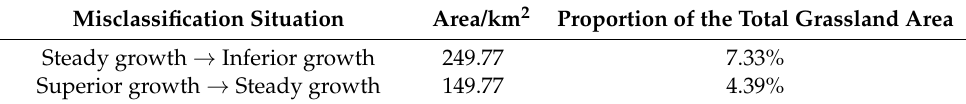
Table 9. Statistics of grassland growth misclassification based on direct mosaic